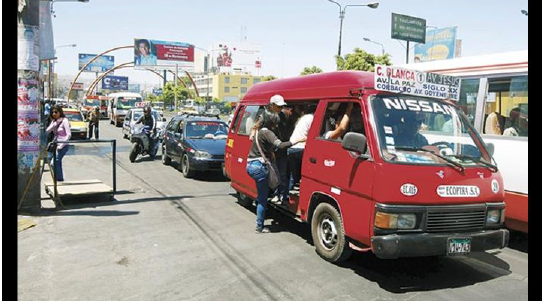
Figure 4. Bus, combi, colectivo.